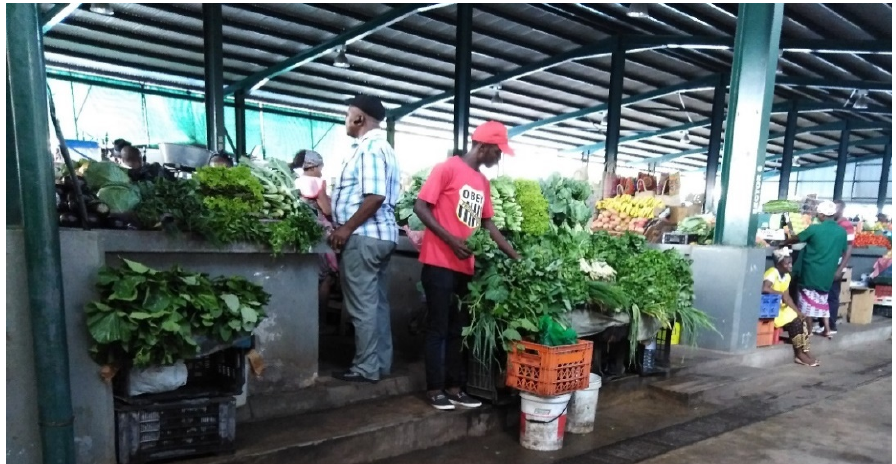
Figure 8. Stands at Central market sufficiently distant from the floor.